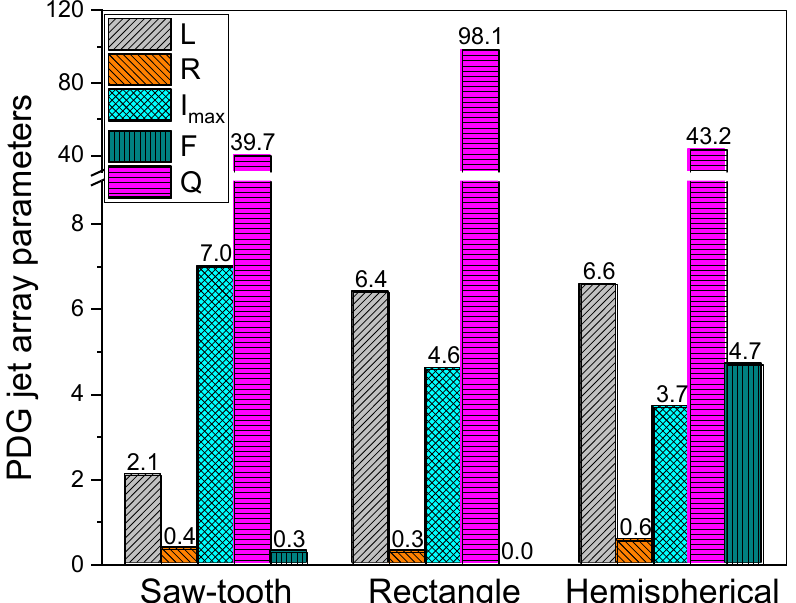
Figure 9. Summary of main PNJ parameters from different PDGs [66].